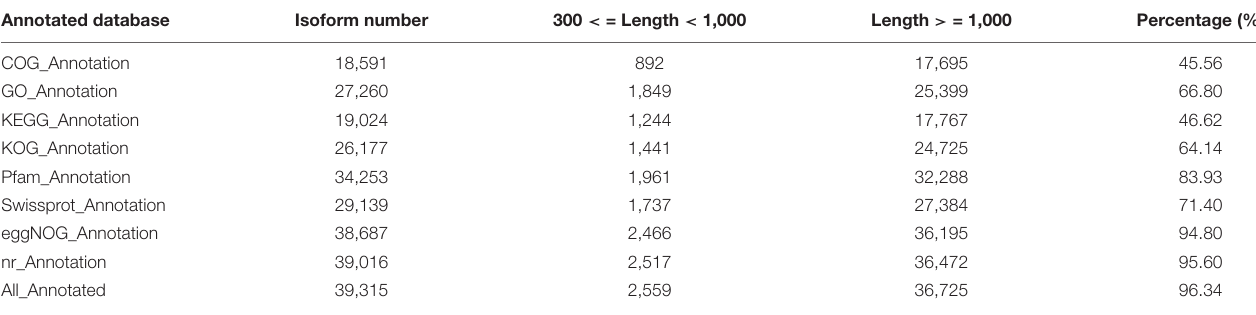
TABLE 2 | Annotated transcripts numbers based on eight databases. Annotated